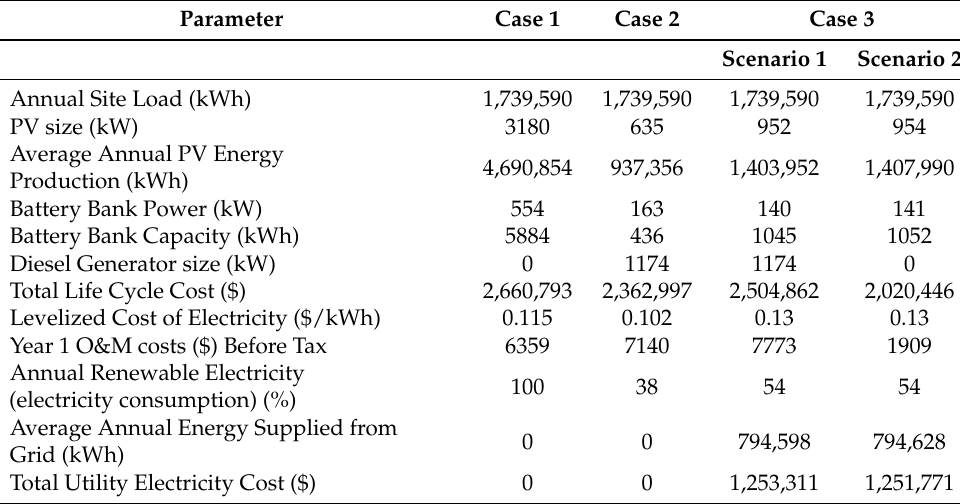
Table 2. Comparison between the three operating